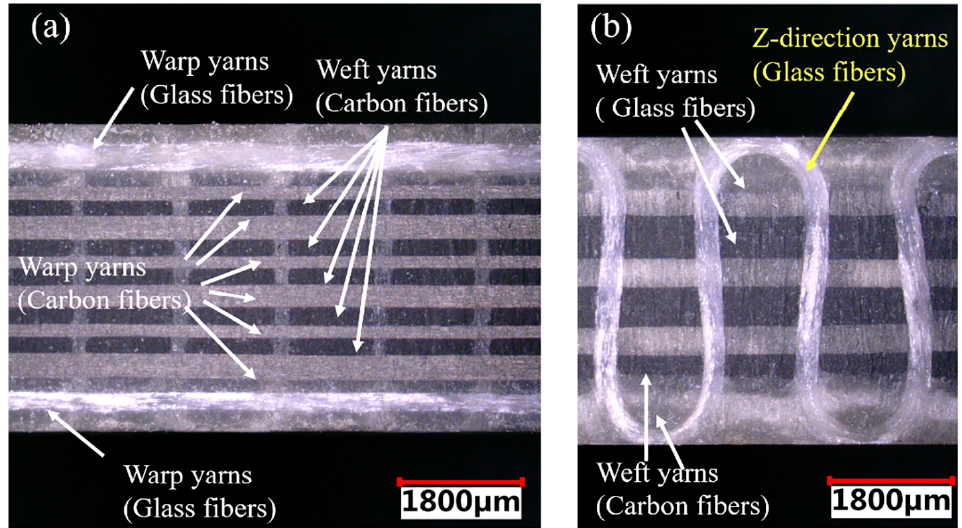
Figure 40. The front ( a ) and back ( b ) cross-sections of the 3D hybrid composite from the weft yarn direction views, adapted with permission from Ref. [127]. Copyright © 2019 Elsevier